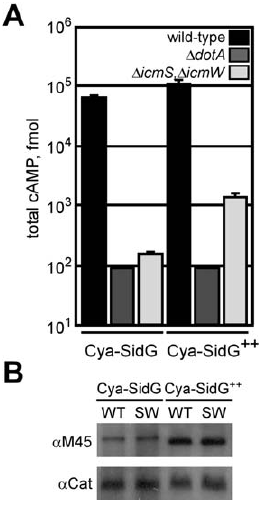
Figure 7. Overproduction of SidG Can Bypass the icmSW Requirement (A) CHO Fc c RII cells were infected with wild-type (black), D dotA (dark grey), or D icmS , D icmW (light grey) L. pneumophila strains expressing the indicated Cya-SidG proteins for 1 h. Cultures that were grown in the presence of 1 mM IPTG prior to and during infection are indicated (Cya- SidG þþ ). Total cAMP production induced by translocation of the hybrid was determined as in Figure 1. (B) Immunoblots of whole-cell bacterial extracts expressing Cya-SidG cultured in the absence or presence of 1 mM IPTG (Cya-SidG þþ ). Proteins from wild-type (WT) or D icmS , D icmW (SW) were probed with monoclonal antibody specific to the M45 epitope. Immunoblots for chloramphenicol acetyltransferase (Cat) are included as a load control.